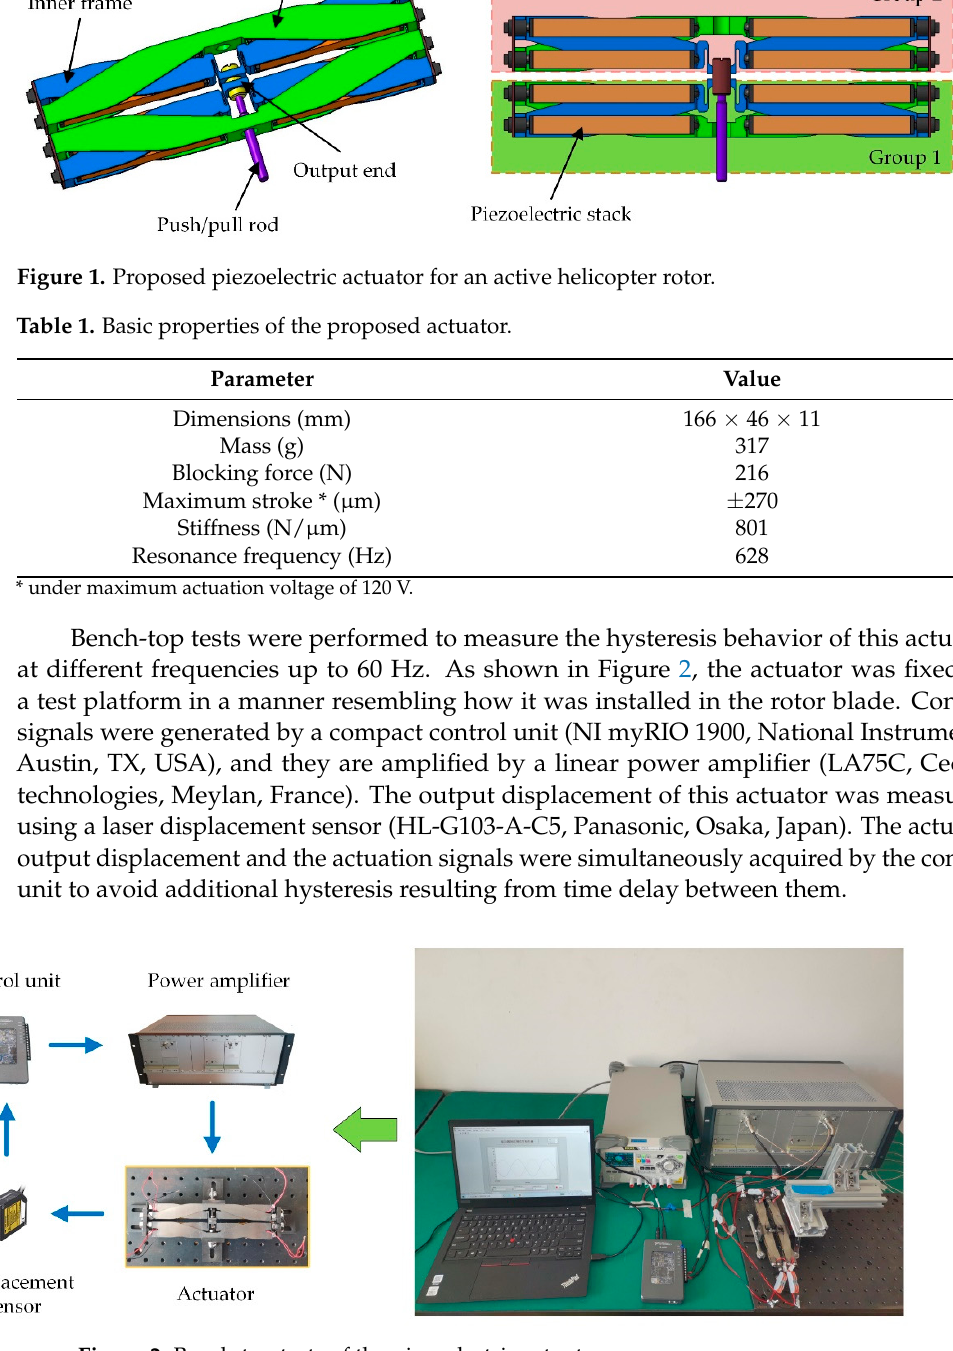
Figure 2. Bench-top tests of the piezoelectric actuator.